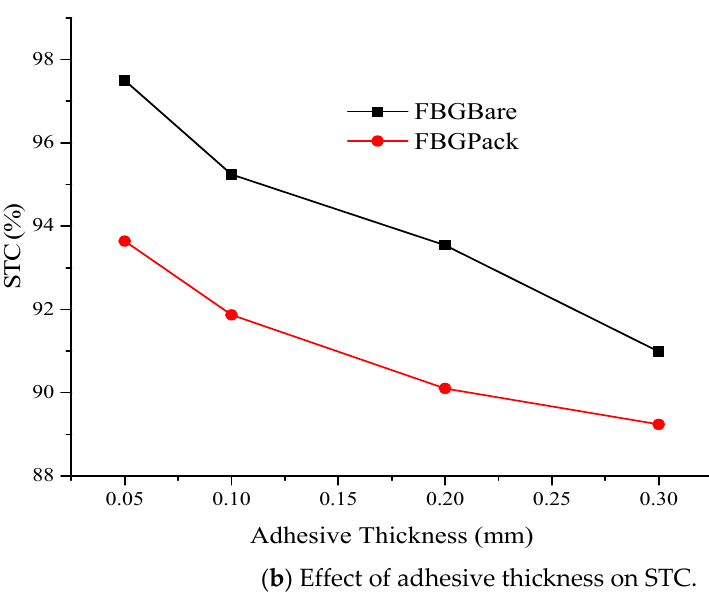
( b ) Effect of adhesive thickness on STC. Figure 10. Sensitivity analysis of FBG Bare and FBG Pack .